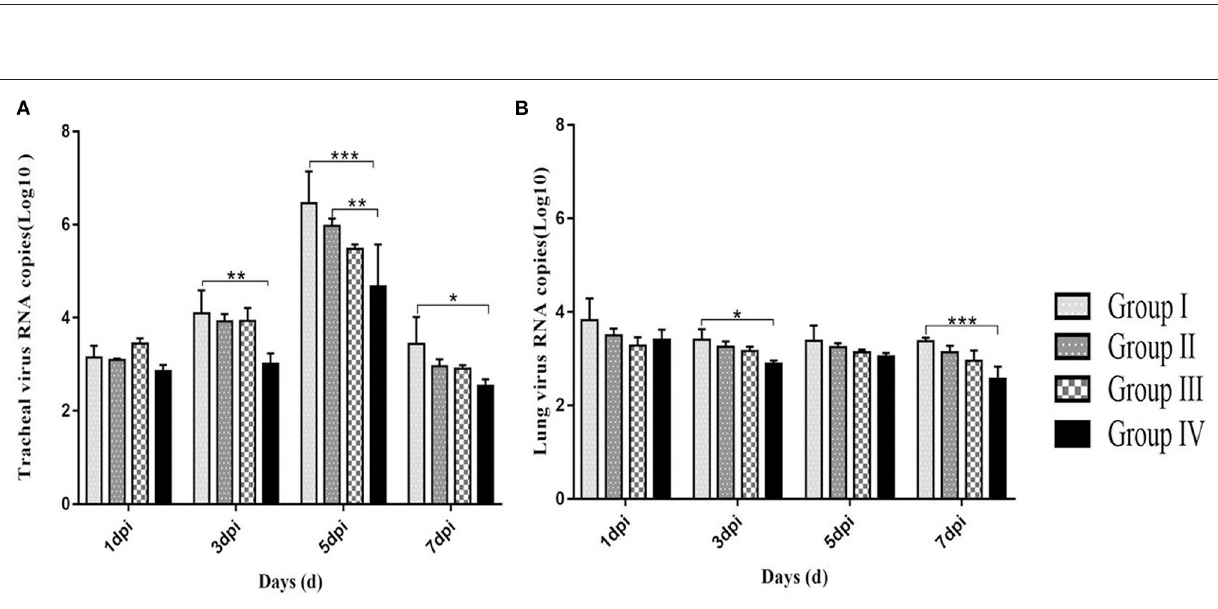
FIGURE 6 | Log10 of IBV RNA copies from tracheas (A) and lungs (B) in 1, 3, 5, and 7 dpi. Group I served as a control. Broilers in Group II were given doxycycline whereas Group III was given SGDL granule through drinking water. Broilers in Group IV were given SGDL granule and doxycycline in drinking water. It was intraocularly and intranasally challenged by IBV at day 28. Extremely significant ( p < 0.005) different values are shown with ***, extremely significant ( p < 0.01) different values are shown with **, significantly ( p < 0.05) different values are shown with *, and no signal was not significantly ( p > 0.05) different between the groups at those time points. SGDL,